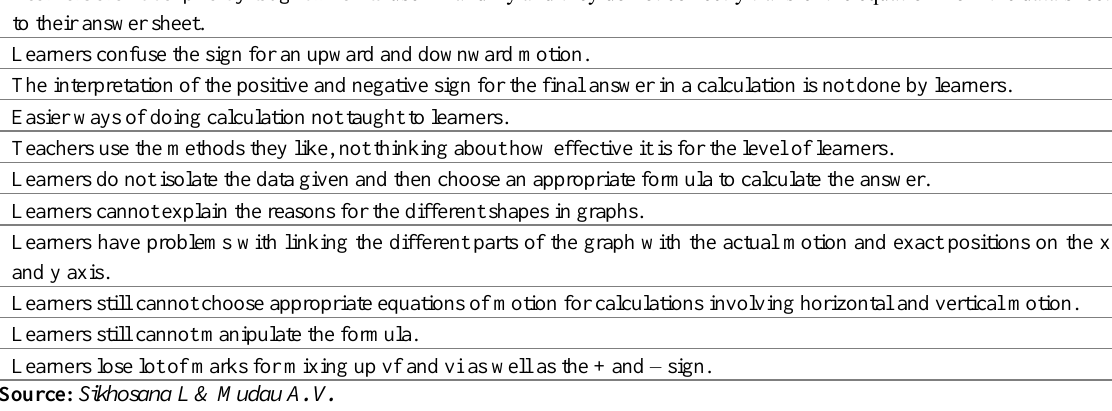
Table 1: Learners Mistakes in Projectile